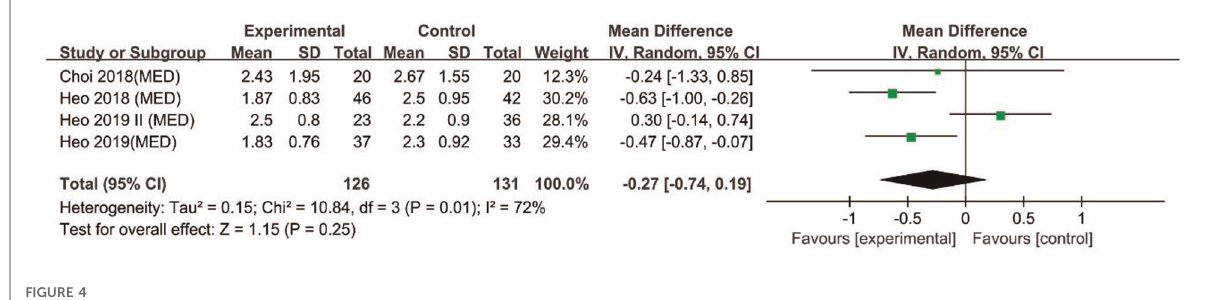
FIGURE 4 Forrest plot of vas leg pain 1-day UBE vs MED.